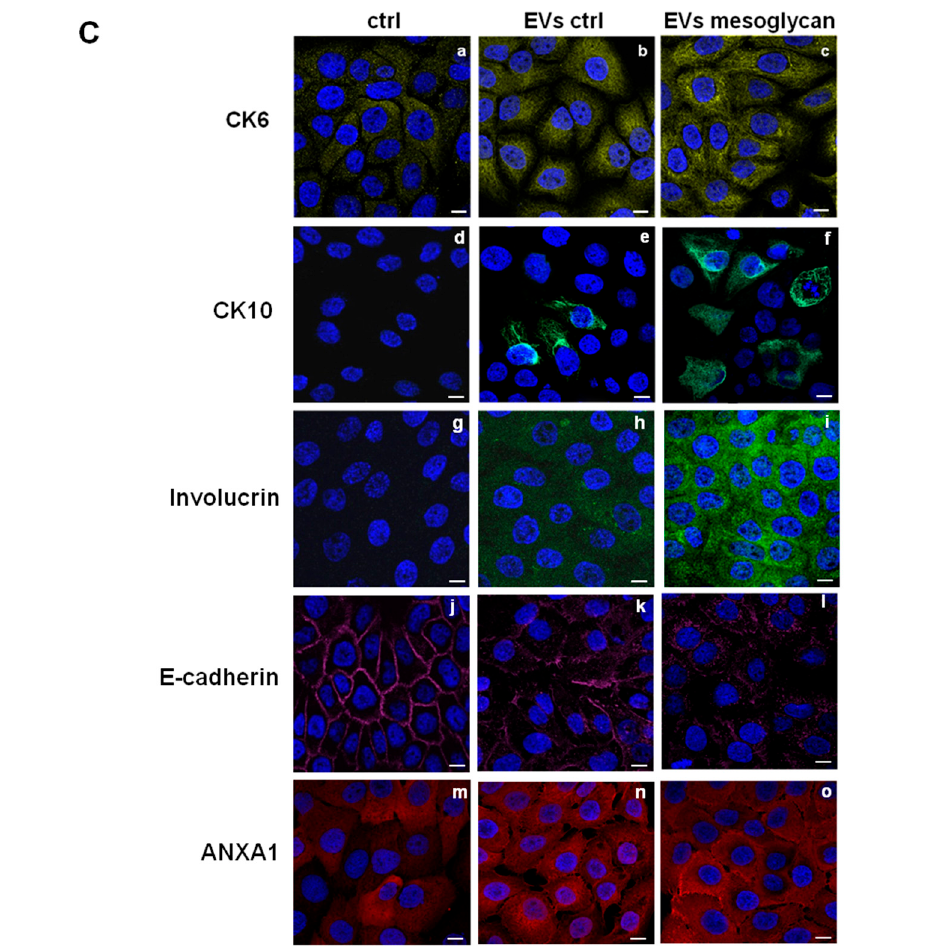
Figure 2. ( A ) Invasion assay on keratinocytes treated with control EVs and EVs released by keratinocytes treated with mesoglycan 0.3 mg / mL. *** p < 0.001 for EVs ctrl and EVs mesoglycan vs. non treated control; aa p < 0.01 for EVs mesoglycan vs. EVs ctrl. This mean derived from cell counts of 10